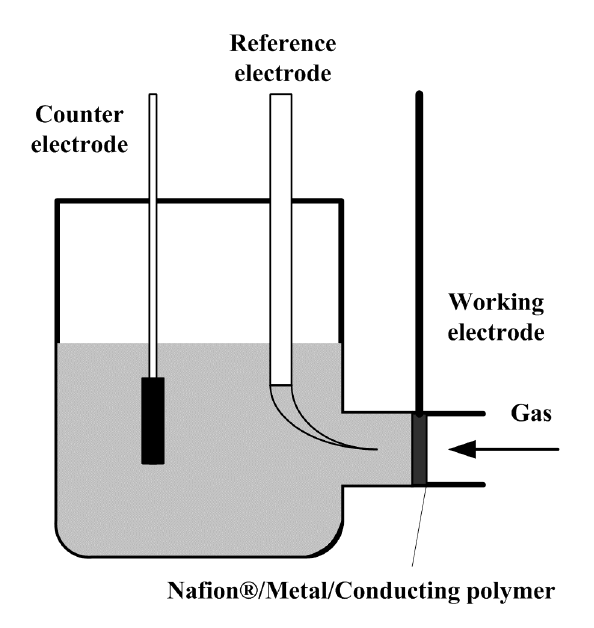
Figure 12. Configuration of a type of electrolytic cell for gas